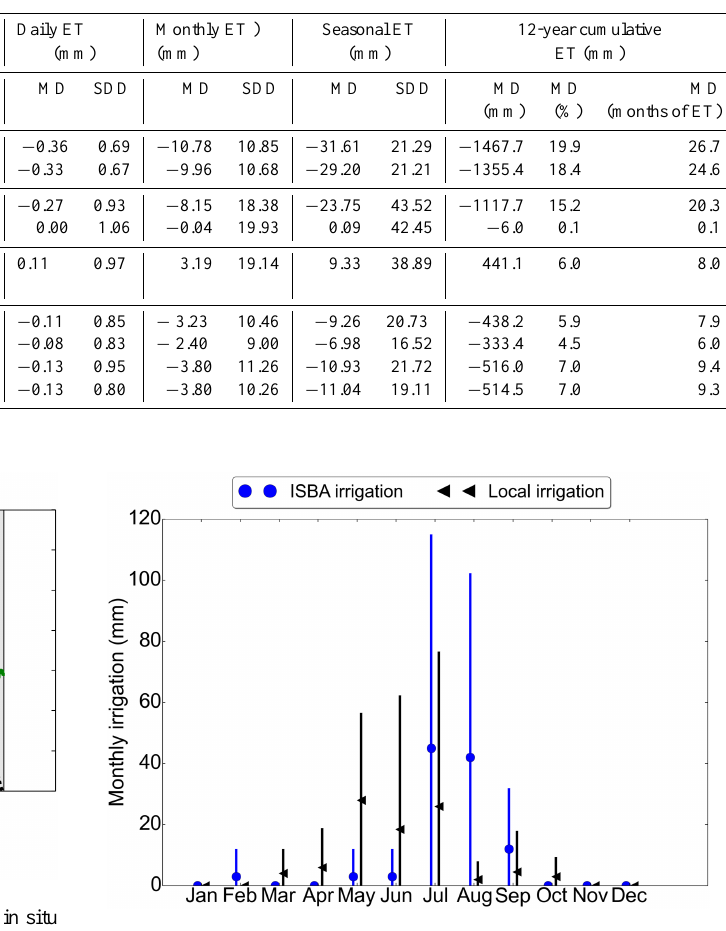
Table 6. Influence of the large-scale forcing variables on simulated evapotranspiration (ET) at half-hourly, daily, monthly, seasonal and multi-year timescales. The mean difference (MD) and the SD of difference (SDD) between each experiment and the control run (S CTL ) are computed over the 25 April 2001–26 June 2012 period. In the last column, MD in cumulative ET over 12 years is given in absolute value and in percentage of the 12-year cumulative ET obtained with the control run. This percentage is translated in equivalent number of months of ET.